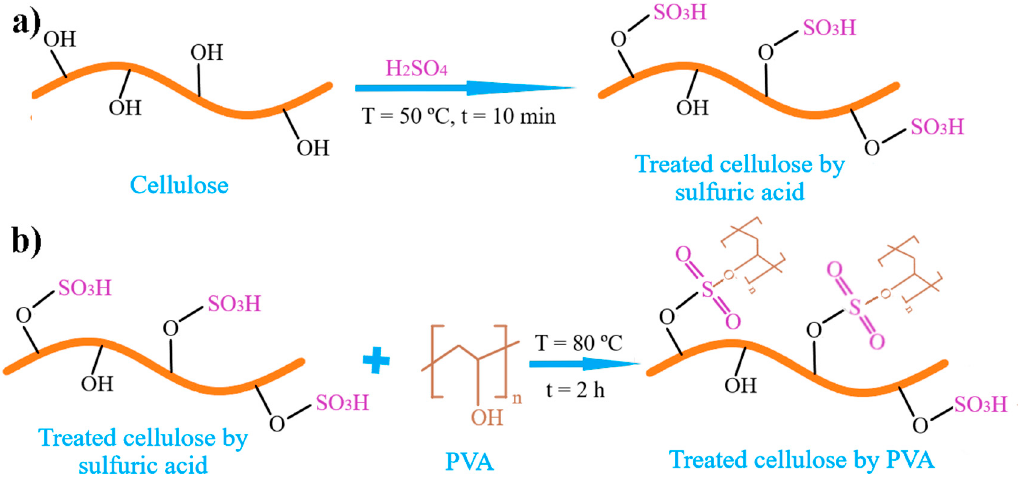
Figure 2. The potential reactions of the glue based on PVA/Cellulose: ( a ) the modifying reaction of cellulose nanoparticles surface by sulfuric acid; ( b ) the reaction between PVA and modified cellulose nanoparticles.